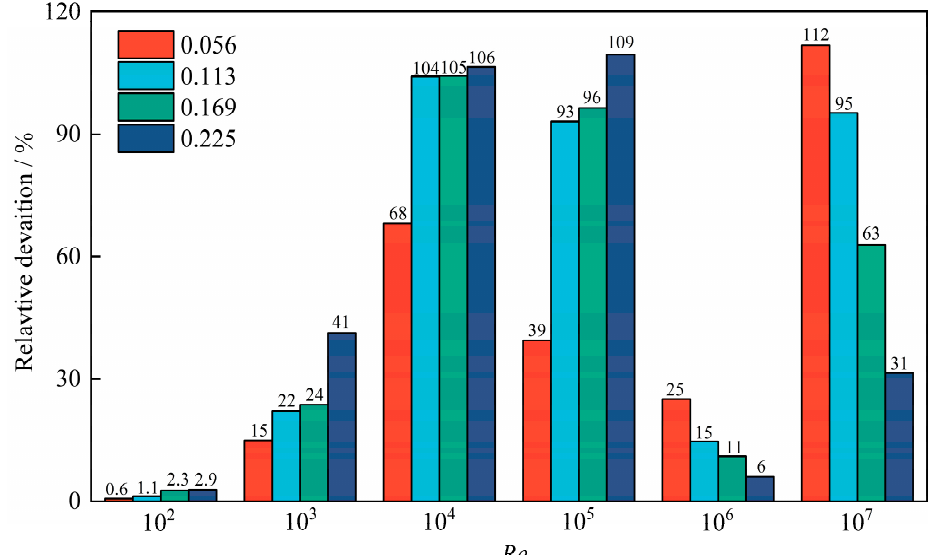
Figure 12. Relative deviations versus Re under η = 0.056~0.225 conditions.